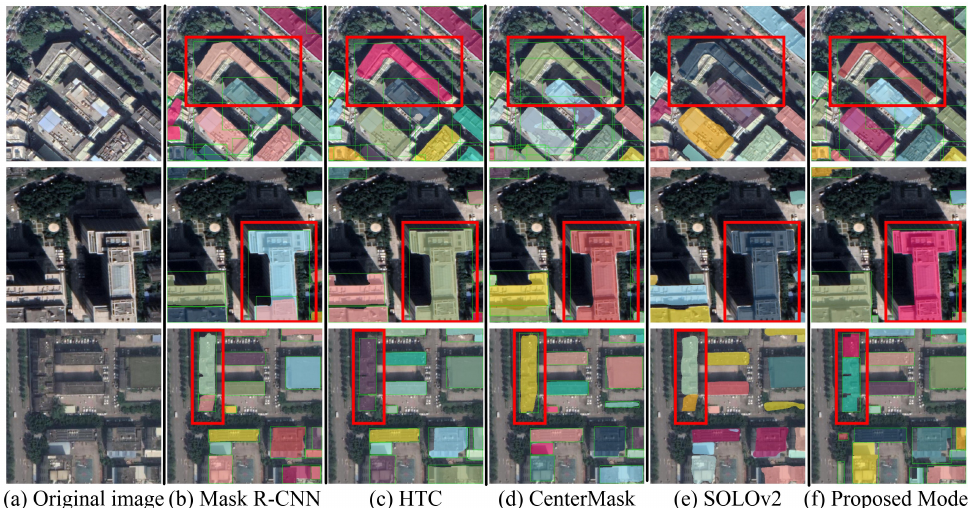
Figure 12. Visualized results of building instance extraction using the self-annotated building instance segmentation Dataset: ( a ) the original remote sensing imagery, ( b ) Mask R-CNN, ( c ) HTC, ( d ) CenterMask, ( e ) SOLOv2, ( f ) Proposed model.